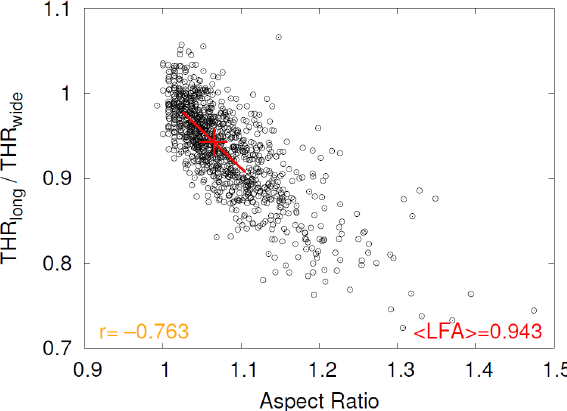
Figure 8. Example of the scatter plot THR long /THR wide versus Aspect Ratio of donor 4 for plasma suspension. For details see text.The correlation coefficient is shown in orange in the lower left corner. The red line is a regression of all data with aspect ratios inside the interval (cid:104) median − 0.04, median + 0.04 (cid:105) , where the median is taken from Figure 7. The red cross indicates the middle of the regression line. The y-position of the red cross denotes the value of LFA corresponding to the median of Aspect Ratio. Its value is shown in red in the lower right